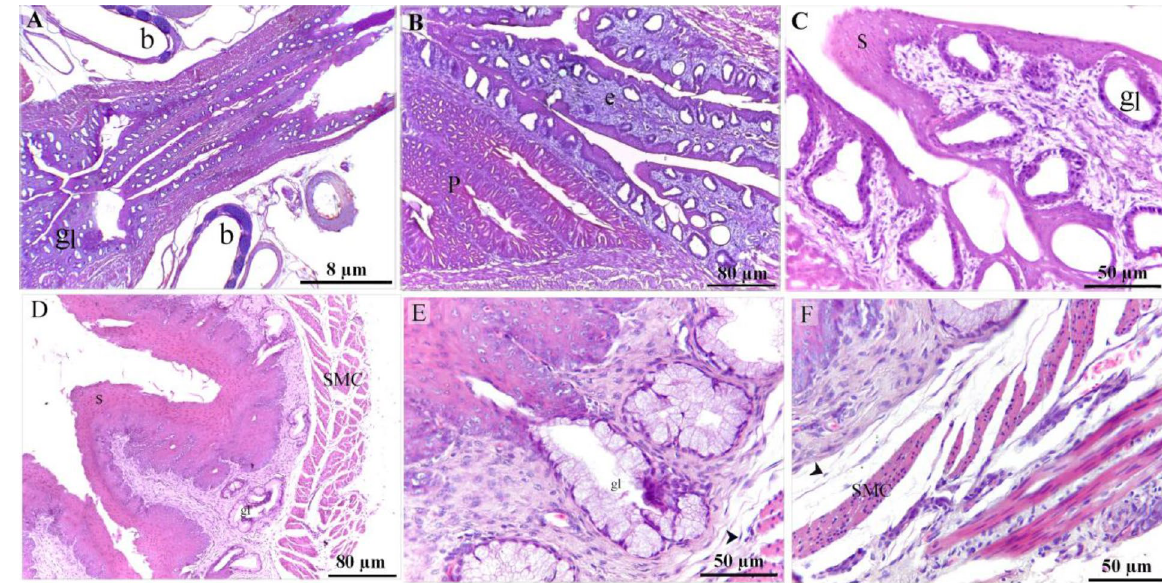
Figure 5. Typical form of avian esophagus. Coronal section of day 15 of quail embryo stained with H&E ( A – F ). A, B: The thoracic portion of the esophagus (e) developed highly folded mucosa which exhibited numerous sac-like glandular units (gl). intrapulmonary bronchi (b). Note. proventriculus (P). ( C ) The thoracic portion of the esophagus was lined by stratified squamous epithelium non-keratinized (s), inactive glands (gl). ( D – F )